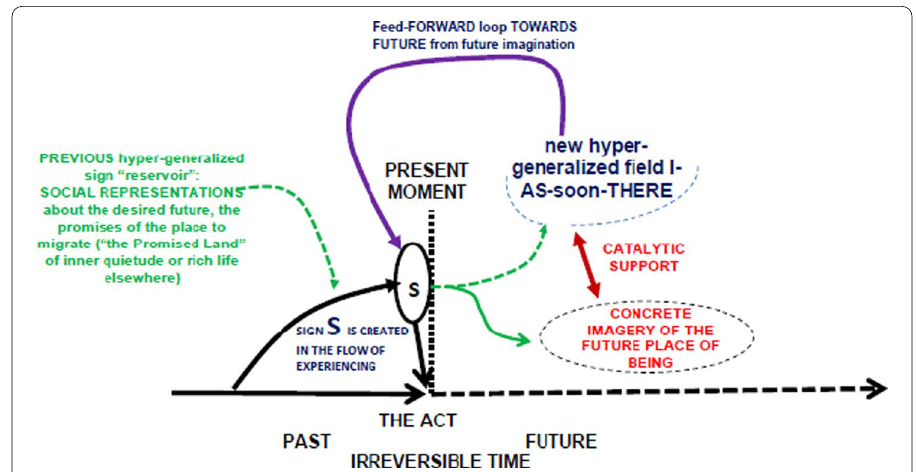
Fig. 1 The feed-forward loop of meaning making in